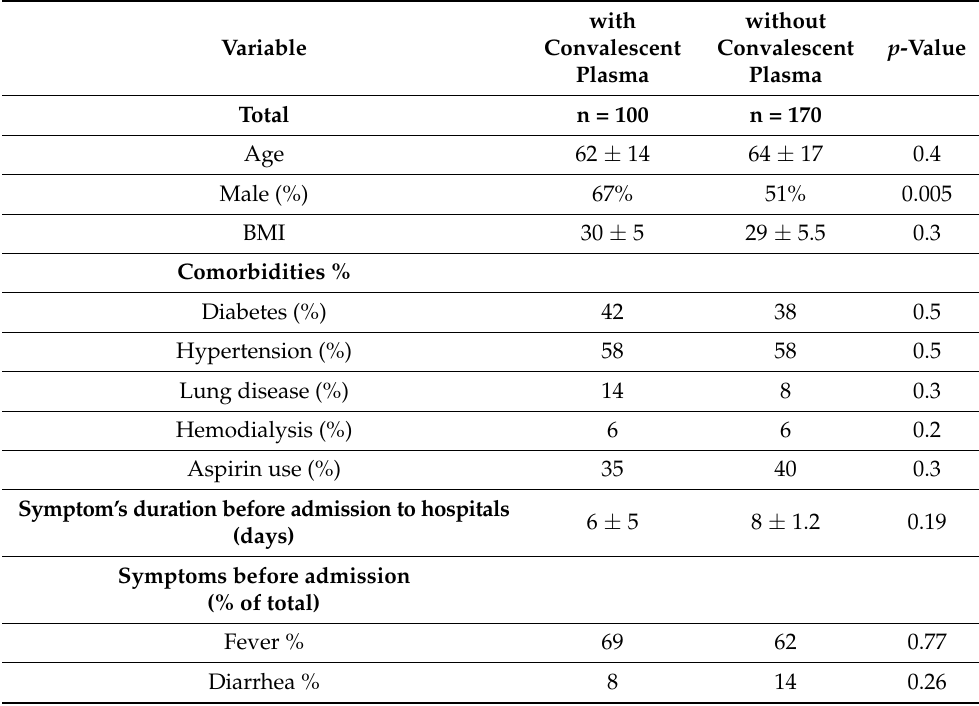
Table 1. Clinical and laboratory characteristics of the COVID-19 patients who were treated with or without convalescent plasma ( p -value <